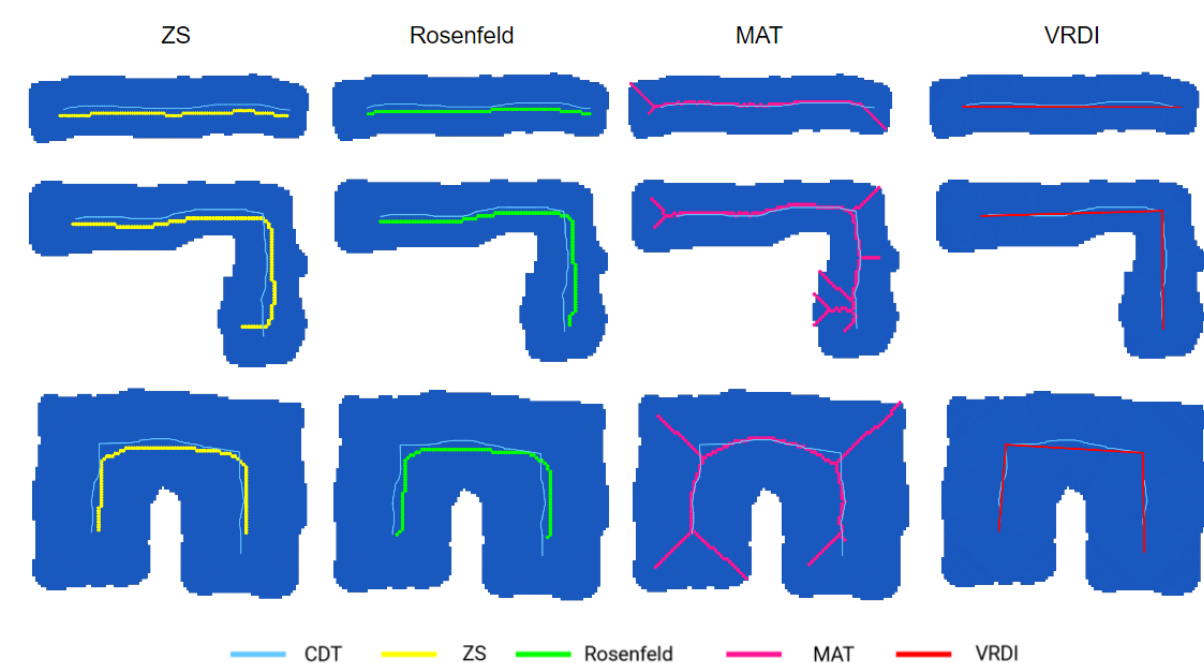
Figure 19. Building skeleton lines with crosspoints. The Fréchet distance between the skeleton line extraction results and CDT method extraction results was calculated, as indicated in Table 1. According to the definition of the Fréchet distance, the distance between the two curves is the length of the shortest suf- ficient for both to traverse their separate paths from start to finish. In other words, a smaller distance corresponds to a skeleton line closer to the center of the building.